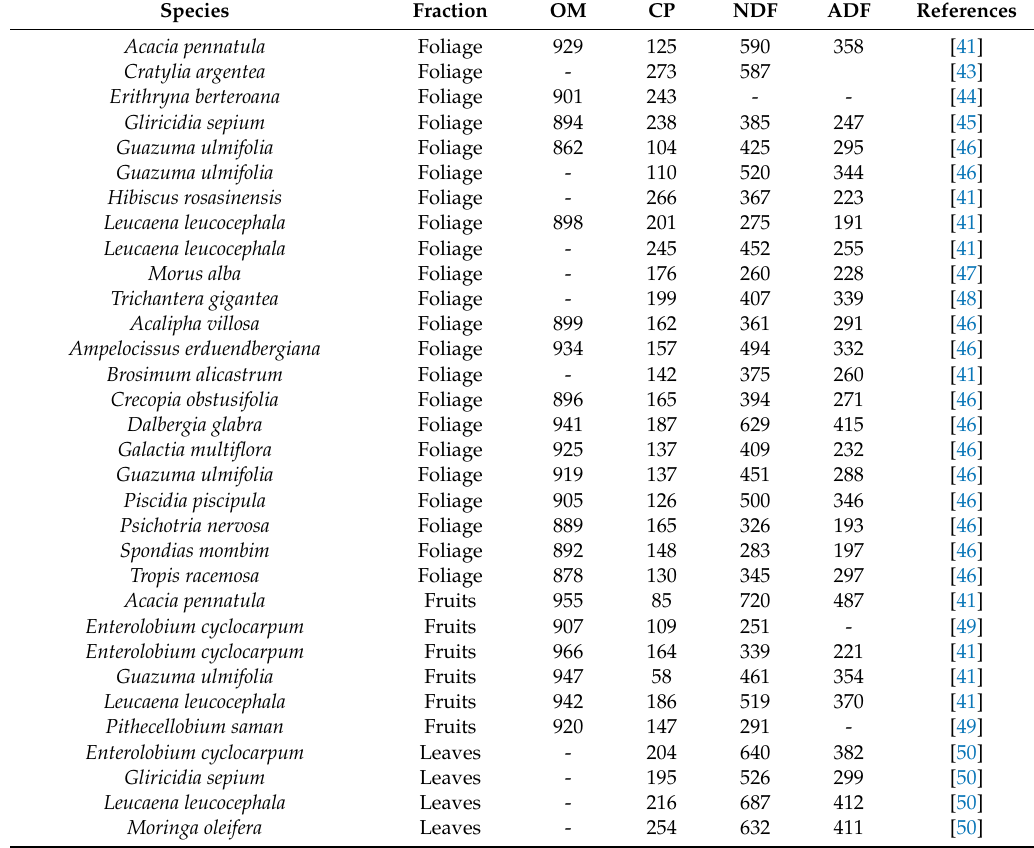
Table 1. Chemical composition (g / kg of dry matter) of foliage, fruits, and leaves of forage